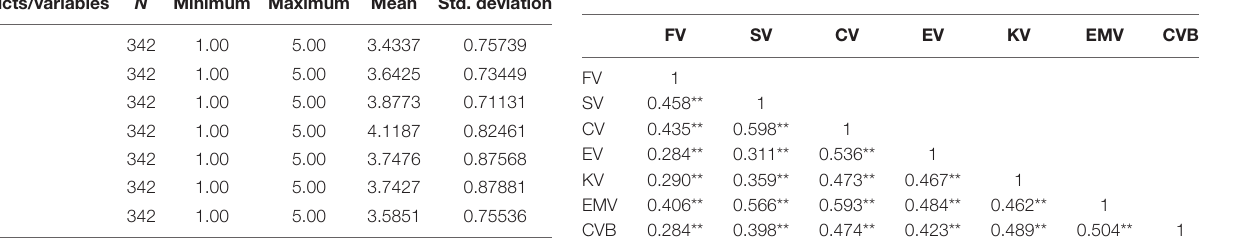
TABLE 8 | Correlation among variables